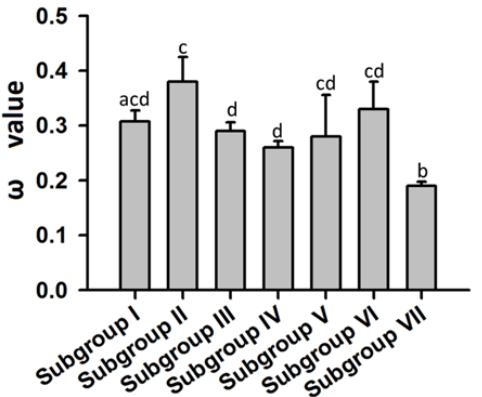
Figure 5. Mean ω values of ALMT genes in different subgroups. Different lowercase letters indicate significant differences among subfamilies ( t -test, LSD test at p < 0.01). Error bars correspond to SE of means.